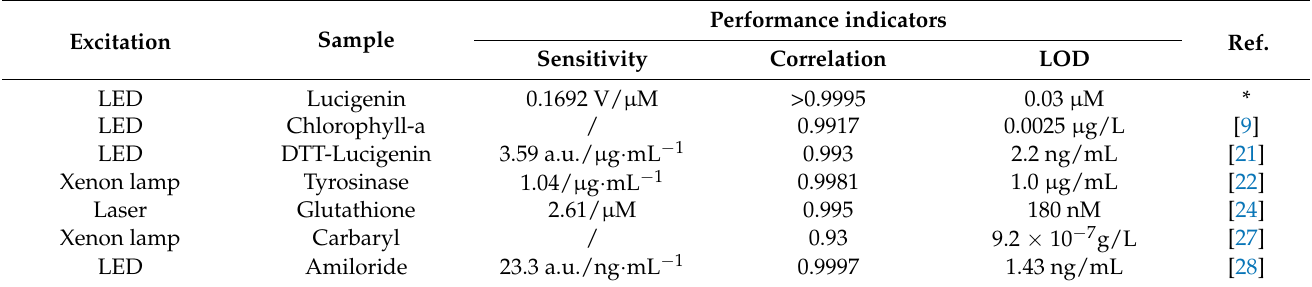
Table 3. Comparison between the integrated fluorescence module and other